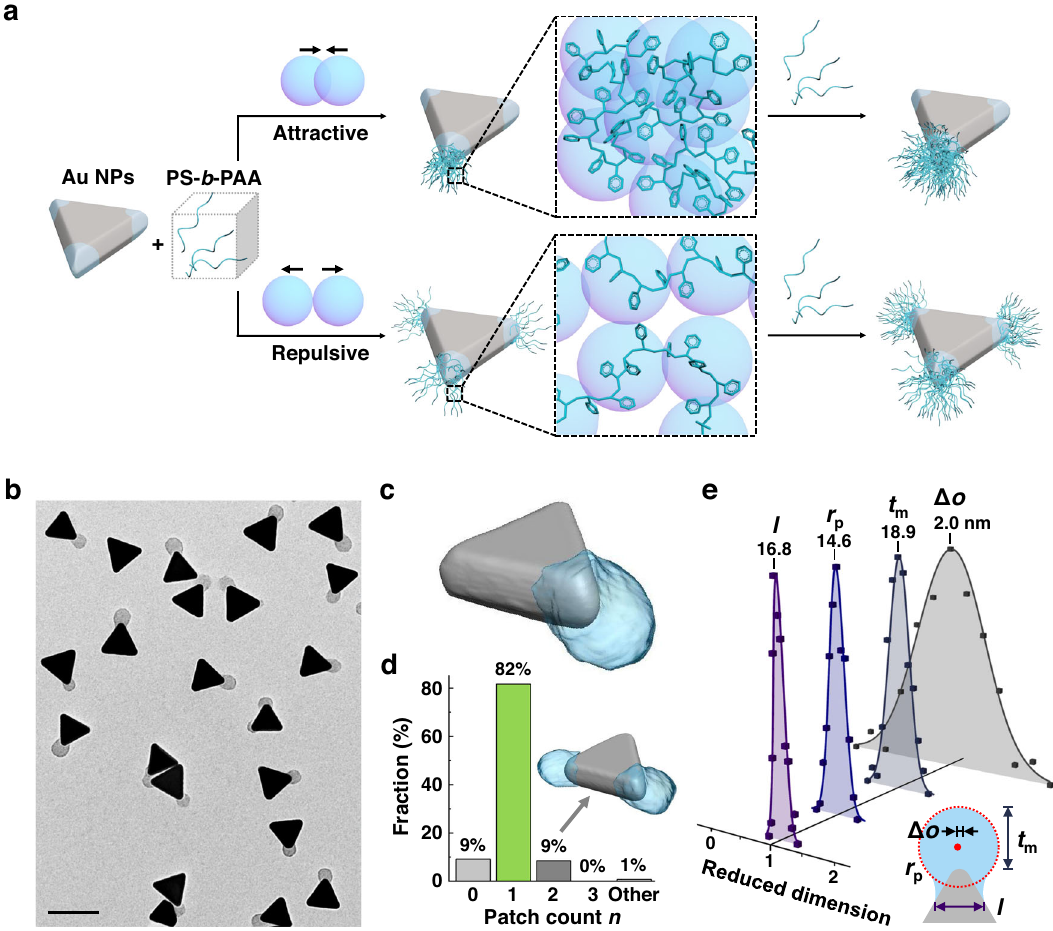
Fig. 1 | High-yieldsynthesisofsymmetry breaking single-patch gold triangular nanoprisms via asymmetric polymer grafting. a Schematics of the asymmetric grafting by controlling the net chain ‒ chain interaction. Net attraction leads to asymmetric single-patch prisms (top), whereas net repulsive interaction leads to symmetric tri-patch prisms (bottom). The prism tip surfaces are hydrophobic as illustrated by the light blue shadows. b Representative TEM image of single-patch gold prisms. c TEM tomography reconstruction of a single-patch prism. d Histogram of patch count per prism n , from the same sample presented in ( b ) (330NPswereanalyzed).The “ Other ” labelcorrespondstoprismswithatleastone